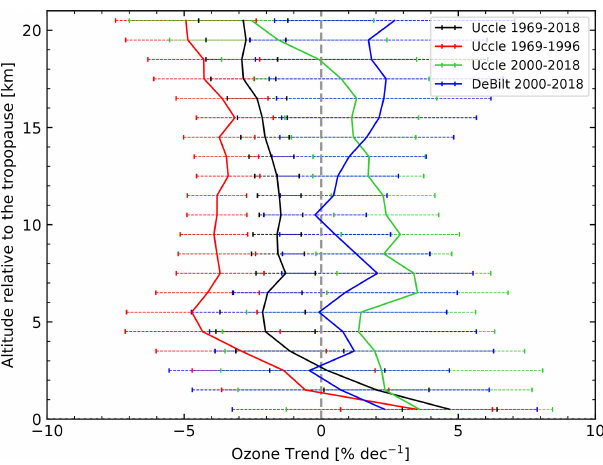
Figure 2. Vertical distribution of trends in stratospheric ozone concentrations at Uccle for different periods (see text) and at De Bilt (2000–2018). The trends and their uncertainties are calculated with the LOTUS multiple linear regression model (see text and SPARC/IO3C/GAW, 2019), including an independent linear trend term. The 2 σ error bars represent the trend uncertainty estimated by the regression model (using the fit residuals). For the Uccle 1969– 2018 time series only, one linear trend term is included in the model instead. The output of the LOTUS MLR model and the different contributing terms for the monthly anomaly ozone concentrations at the layer 10km above the tropopause are shown in Fig. S5.